Question: Summarize what this figure shows in one sentence.
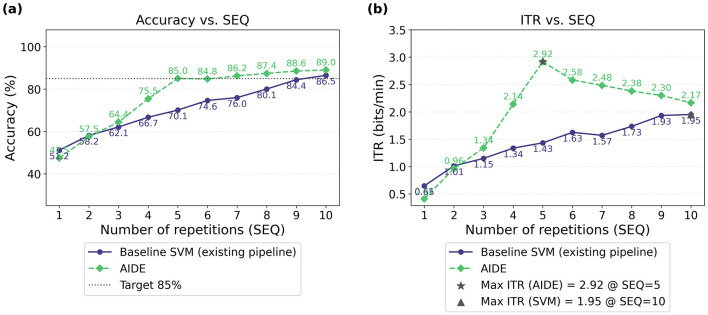
Answer: Effect of stimulus sequences on BCI performance for the AIDE and the baseline SVM. Data points are mean StratifiedKFold accuracies. (a) Classification accuracy vs. SEQ. The dotted line marks the 85% accuracy target. (b) ITR vs. SEQ. Filled markers indicate the peak ITR for each model.